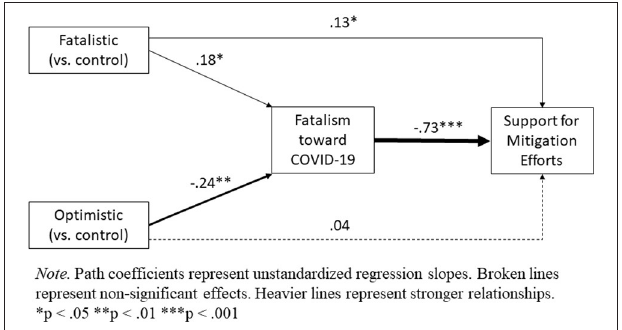
FIGURE 4 | Effect of Messaging Condition on Emotional